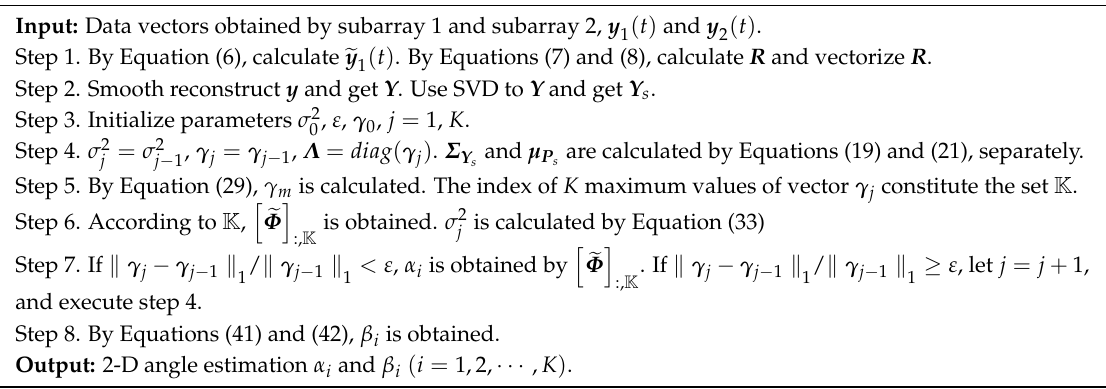
Algorithm 1. The proposed algorithm steps for the 2-D angle estimation of parallel nested